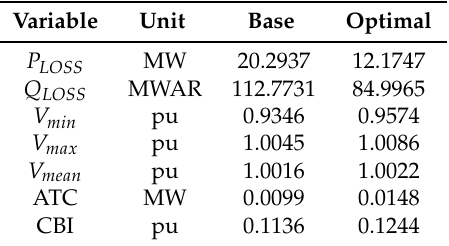
Figure 9. IEEE 57-System generators’ outputs for T32: 12–24. Table 6. Analysis of optimal solution point for T32: